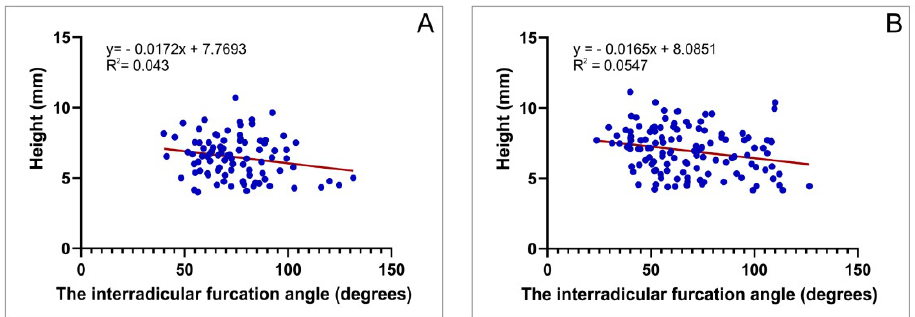
Figure 10. The correlation between the interradicular furcation angle and interradicular septum height: ( A ) the first maxillary molars and ( B ) the second maxillary molars.